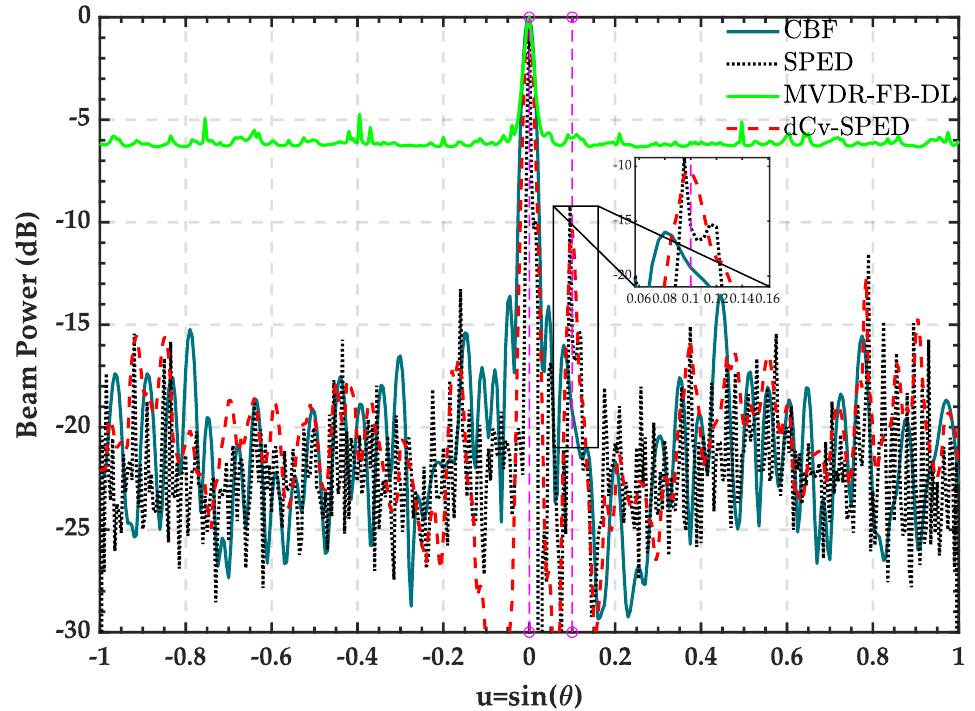
Figure 10. Spatial-spectra estimated by the CBF, SPED, MVDR-FB-FL, and dCv-SPED under array perturbations when the noise was 10 dB.